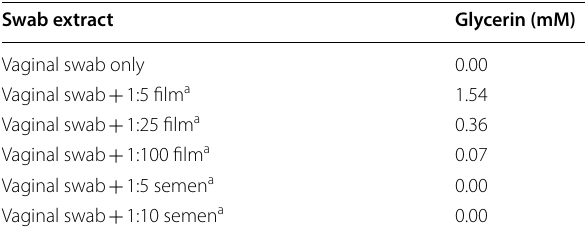
Table 2 Measuring glycerin as a marker for the presence of vaginal